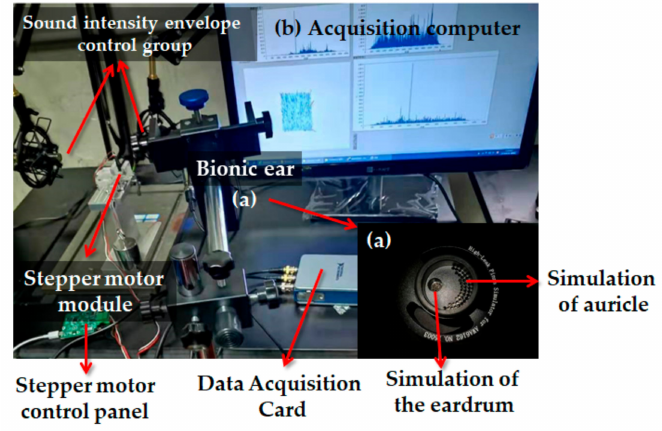
Figure 2. Apparatus of the proposed inspection system. ( a ) Bionic ear; ( b ) Acquisition computer.